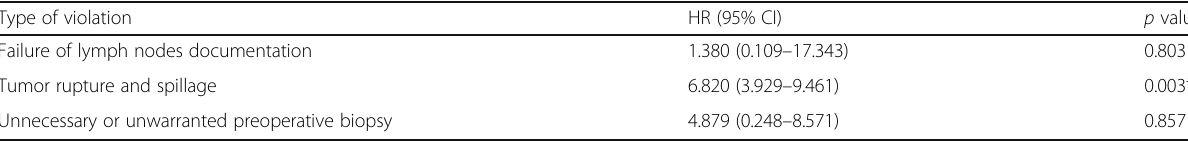
Table 3 The logistic regression of types of surgical violations on relapse Type of